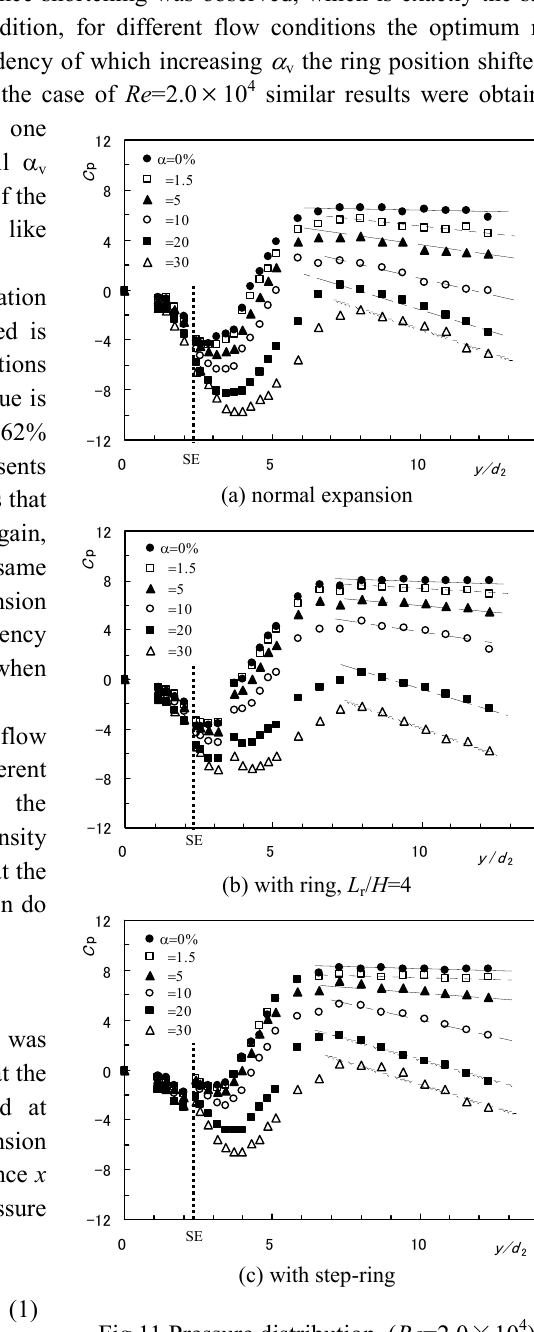
Fig.11 Pressure distribution, ( Re =2.0 × 10 4